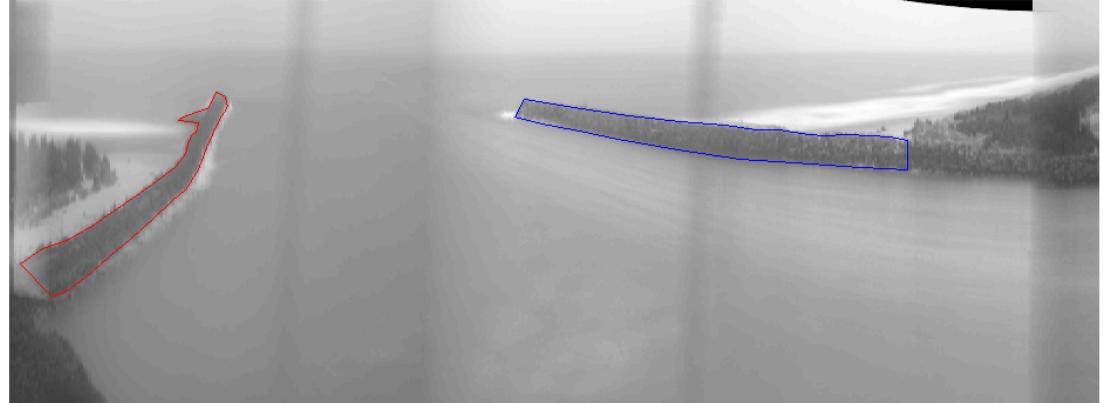
Figure 19. Regions of interest (ROIs) for wave breaking over the Coos Bay jetties with the north jetty ROI marked in blue and the south in red. The regions were manually delineated using this bin-averaged pan for the smallest wave height and lowest tide bin that averages 96 cases.